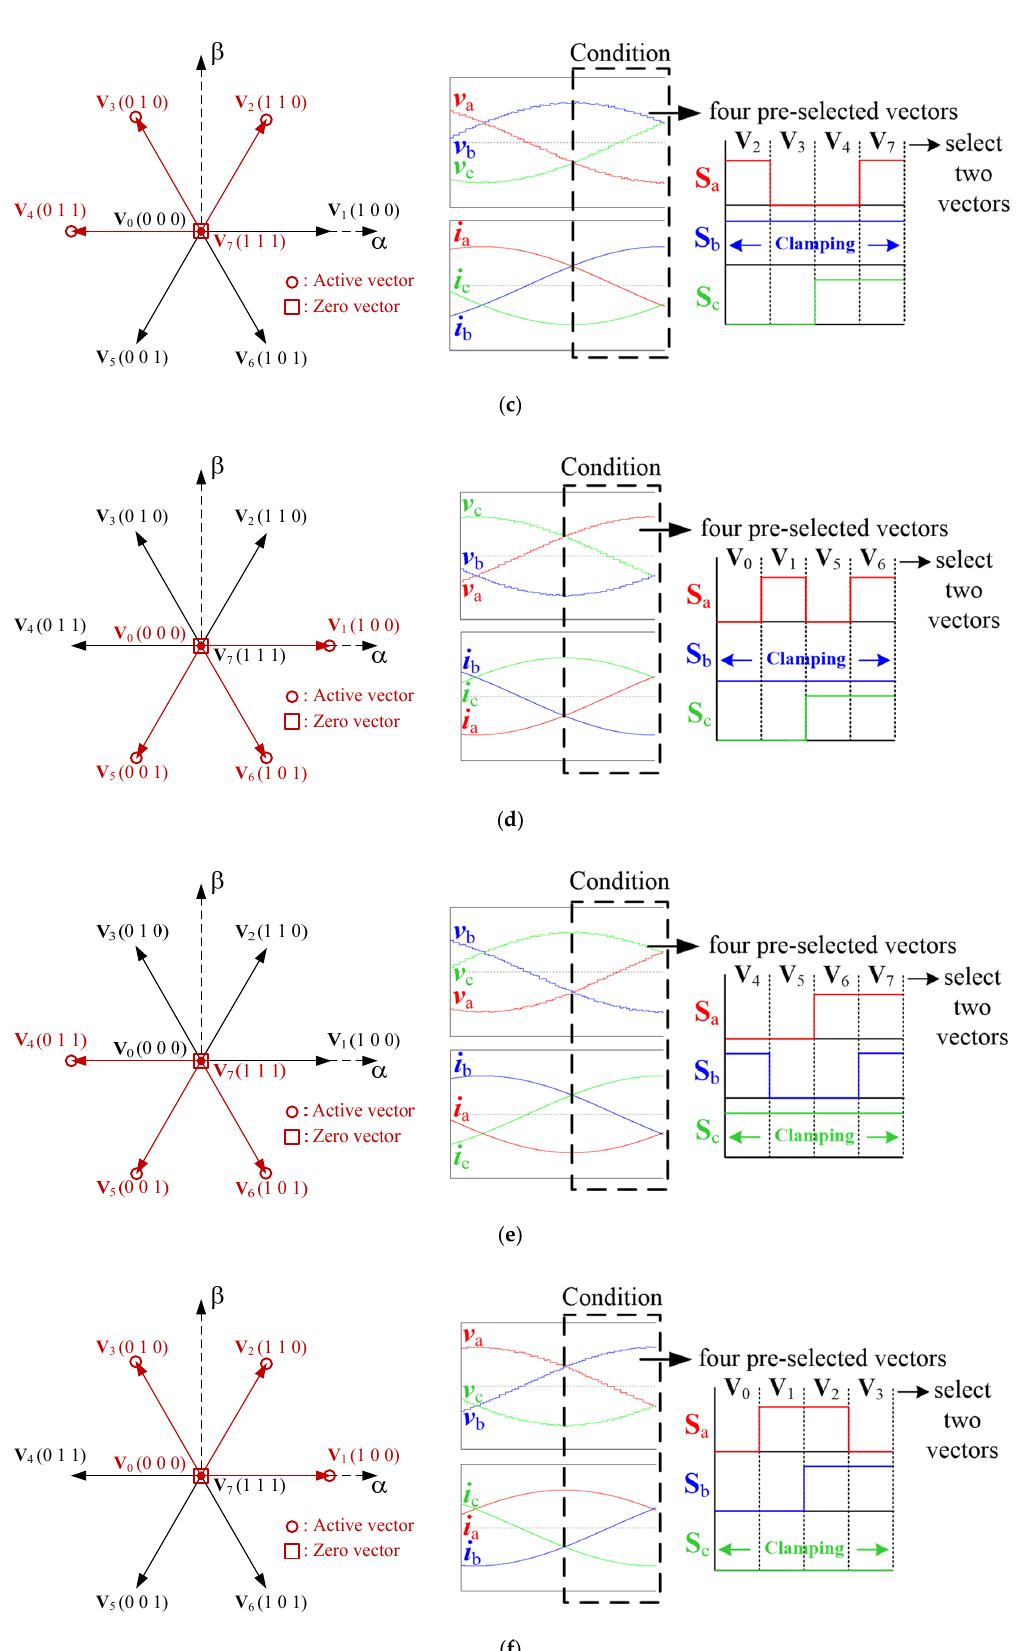
Figure 3. Pre-selected vectors and switching states according to current and voltage with clamped switches ( a ) S 1 , ( b ) S 2 , ( c ) S 3 , ( d ) S 4 , ( e ) S 5 , and ( f ) S 6